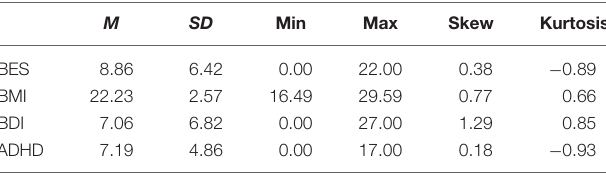
TABLE 6 | Descriptive Statistics associated with binge eating, body mass index, depression, and ADHD symptoms.